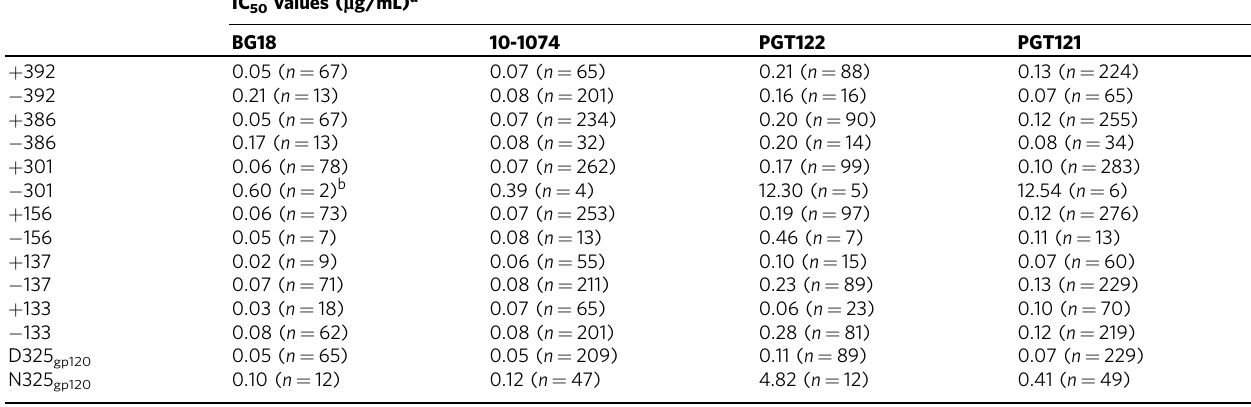
Table 2 Glycan and sequence preference for V3/N332 gp120 targeting bNAbs in the presence of N332 gp120 glycan